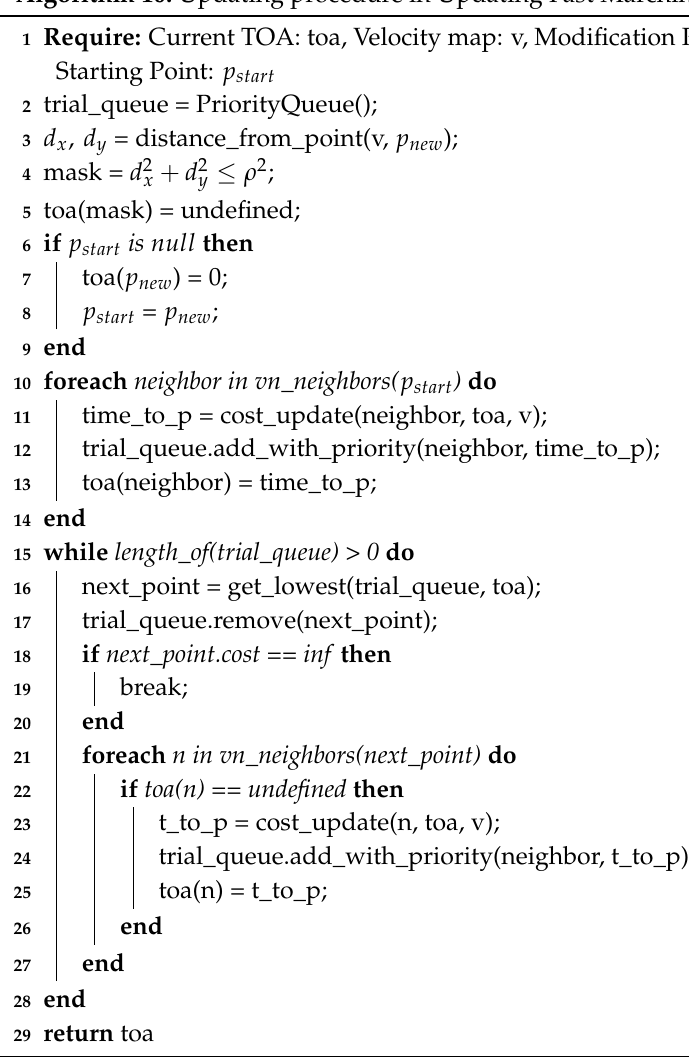
Algorithm 10: Updating procedure in Updating Fast Marching Square Method